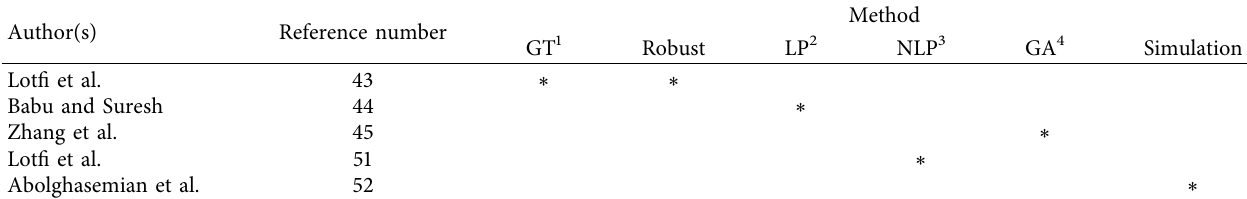
Table 1: Categorized previous